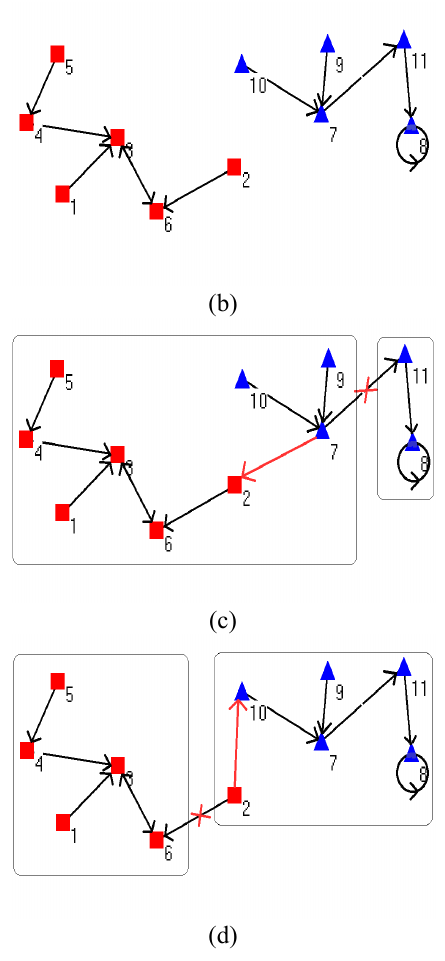
Fig. 3. (Color online) An illustration of the mutation operation for the network in Fig. 1(a). Note that, in order to depict the mutation process more clearly, here we adopt the directed graph to express a chromosome. (a) An arbitrary chromosome A ; (b) Its corresponding directed graph G ; (c) A single mutation operation on non-marginal node 7 for chromosome A , which results in splitting and/or merging communities; (d) A single mutation operation on marginal node 2 for chromosome A , which implements this node’s movement from the red community to the blue one, and does not result in merging or splitting